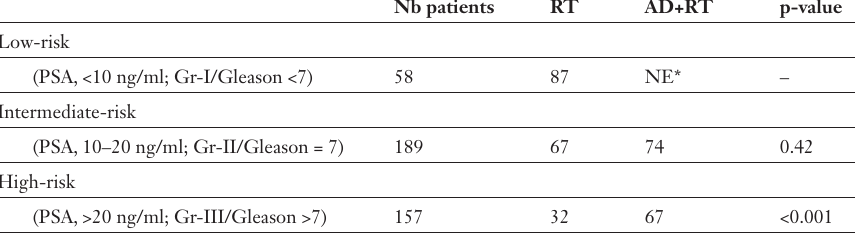
5-year biochemical disease-free survival (%) and risk groups (see text).